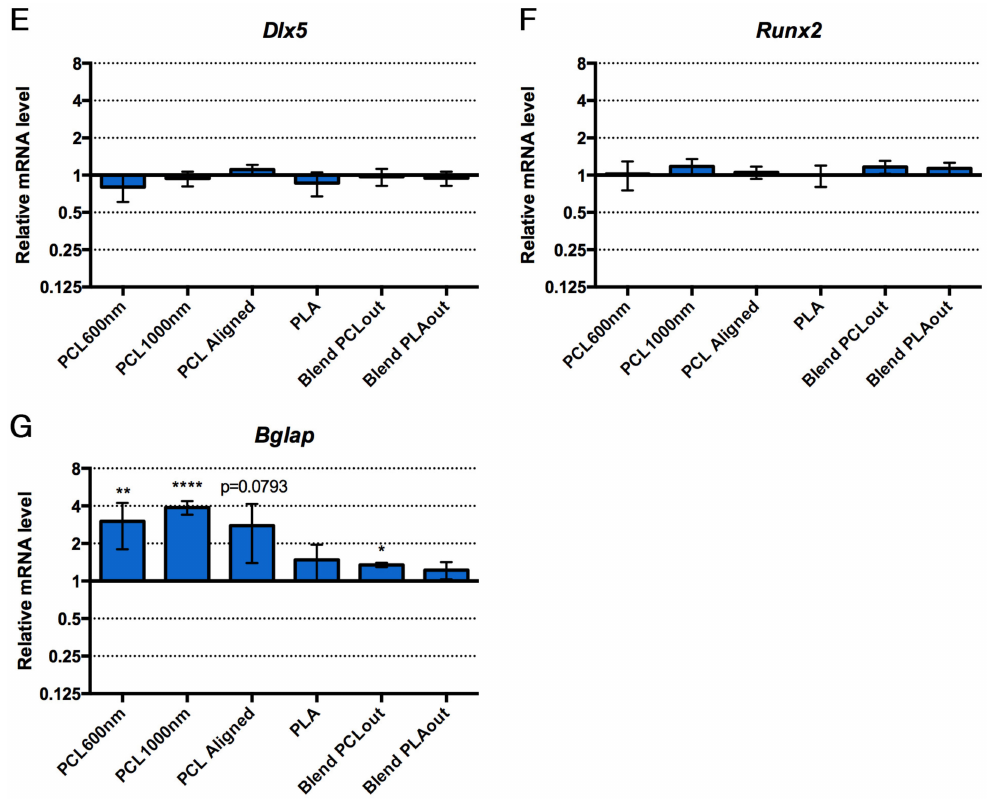
Figure 6. Relative expression of mRNA levels for tendon-related genes, Scx ( A ); Tnmd ( B ); Aqp1 ( C ); ( green bars ) and bone-related genes, Dlx5 ( E ); Runx2 ( F ); Bglap ( G ); ( blue bars ) in C3H10T1/3 cells cultured on the different electrospun scaffolds compared to control conditions (cells without scaffold). Col1a1 , a component of tendon and bone and is represented in dark green bars ( D ). Control conditions have been normalized to 1. Error bars represent s.d. * p < 0.05, ** p < 0.01, *** p < 0.001, **** p <